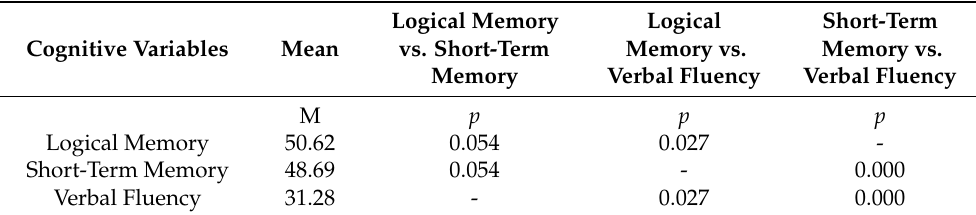
Table 5. Relationships between cognitive variables.